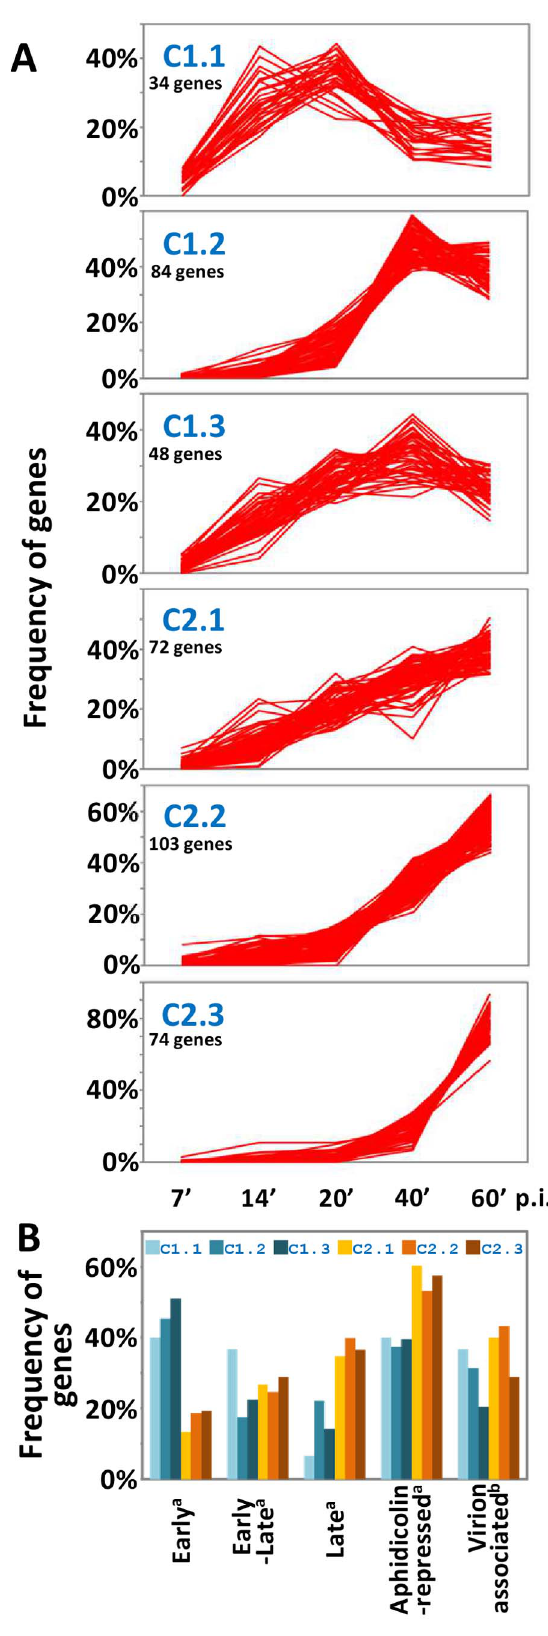
Figure 3. Cluster analysis of PBCV-1 gene expression profiles. (A) Line plot of normalized read counts of PBCV-1 genes for six K-means